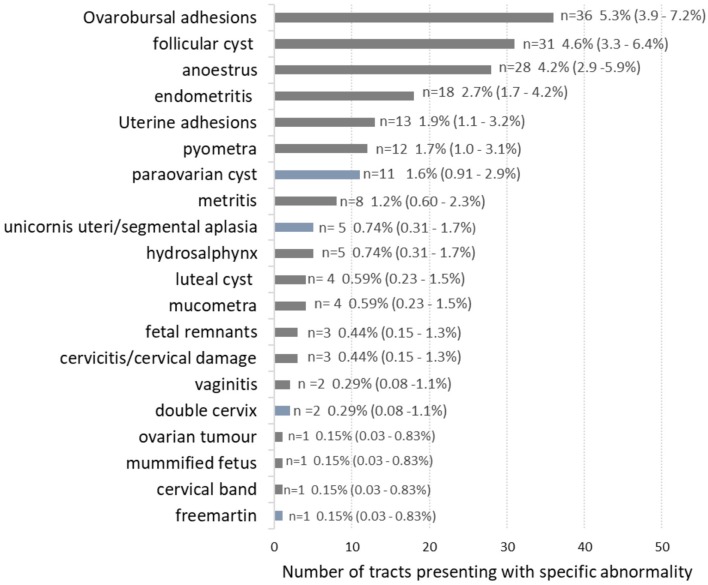
The number of female bovine reproductive tracts exhibiting specific abnormalities. Blue bars highlight congenital lesions, grey bars are acquired lesions. In total, there were 141 individual tracts with abnormalities, but because some tracts had more than one type of abnormality the numbers in the figure tally to 189. Prevalence as a percentage of all tracts examined (n = 680) with 95% confidence interval in brackets.